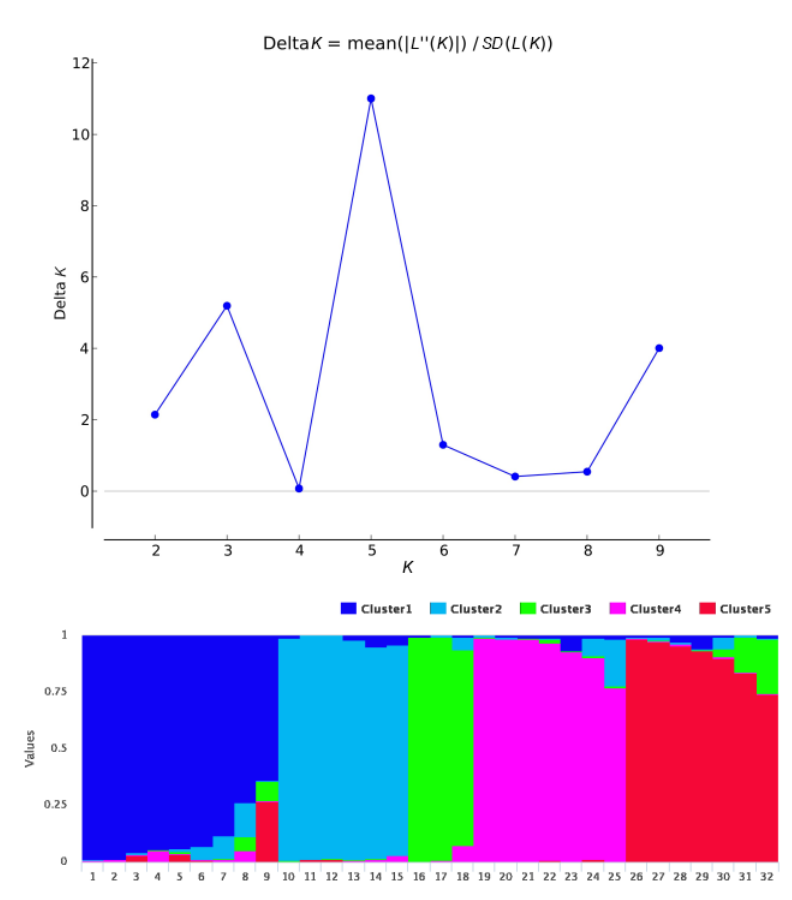
Figure 1 Population structure of 32 barley accessions genotyped using 26 markers. Means of log likelihoods and their standard deviations computed with STRUCTURE software over 10 runs and for a number ( K ) of expected clusters ranging from 1 to 10 and ∆ K values as a function of K (Figure 2A). As indicated in this figure, K value for 5 was optimal. This indicates that accessions could be divided into 5 clusters. Each cluster was represented by different color (Figure